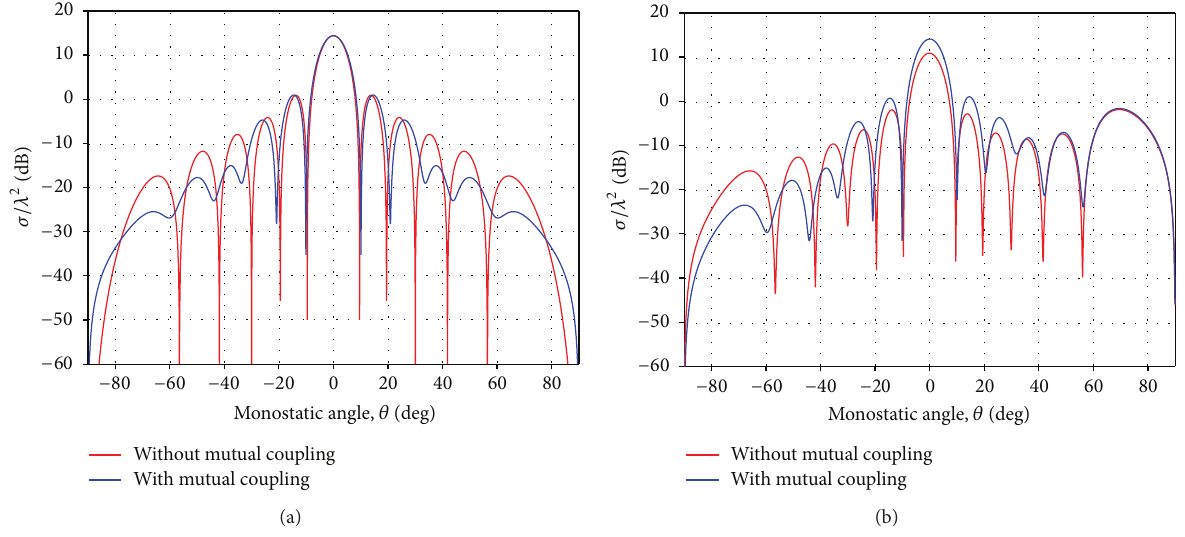
Figure 11: Effect of mutual coupling on RCS of series-fed linear side-by-side dipole array of 𝑁 = 30 , 𝜓 = 𝜋/2 , 𝑑 = 0.1𝜆 , 𝑙 = 0.5𝜆 , 𝑎 = 10 −5 𝜆 , = 150 Ω , and 𝑍 = 280 Ω ; unit amplitude uniform distribution. (a) 𝜃 𝑍 0 𝑙